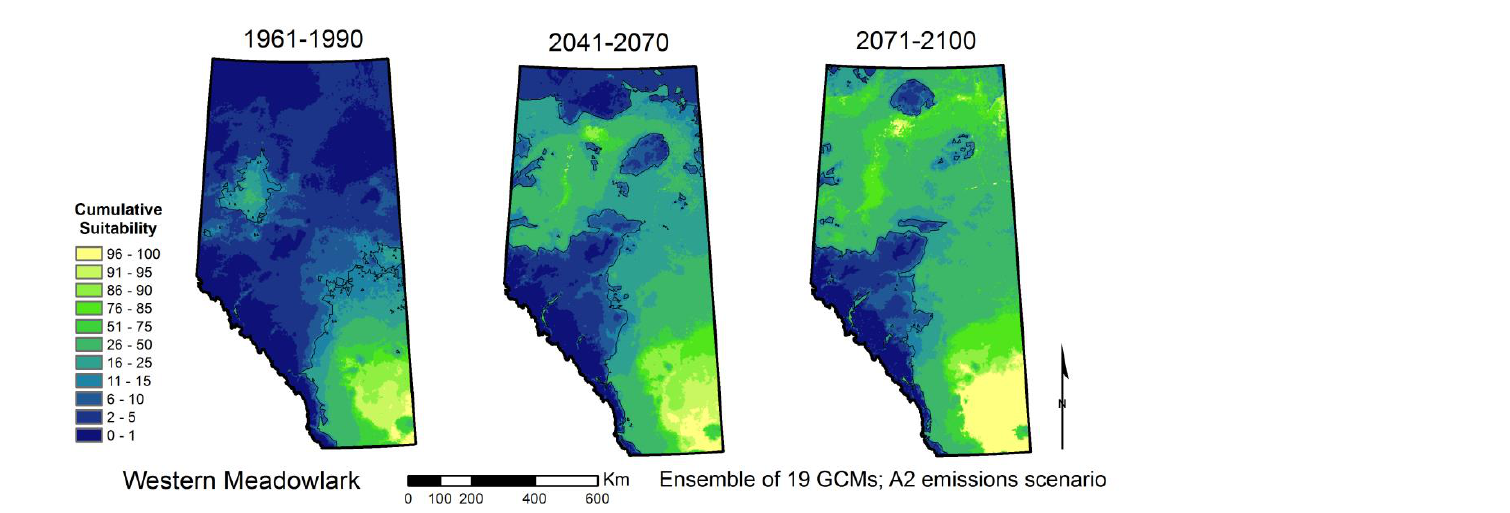
Figure A3.2. Baseline predictions (1961-1990) and future projections (2041-2070 and 2071-2100) of climate suitability for 15 grassland songbirds in Alberta, Canada, based on North American models. The black line delineates core suitable climate area for each species as determined by species specific thresholds. Future projections are based on ensemble climate data from 19 global climate models and the A2 SRES emissions